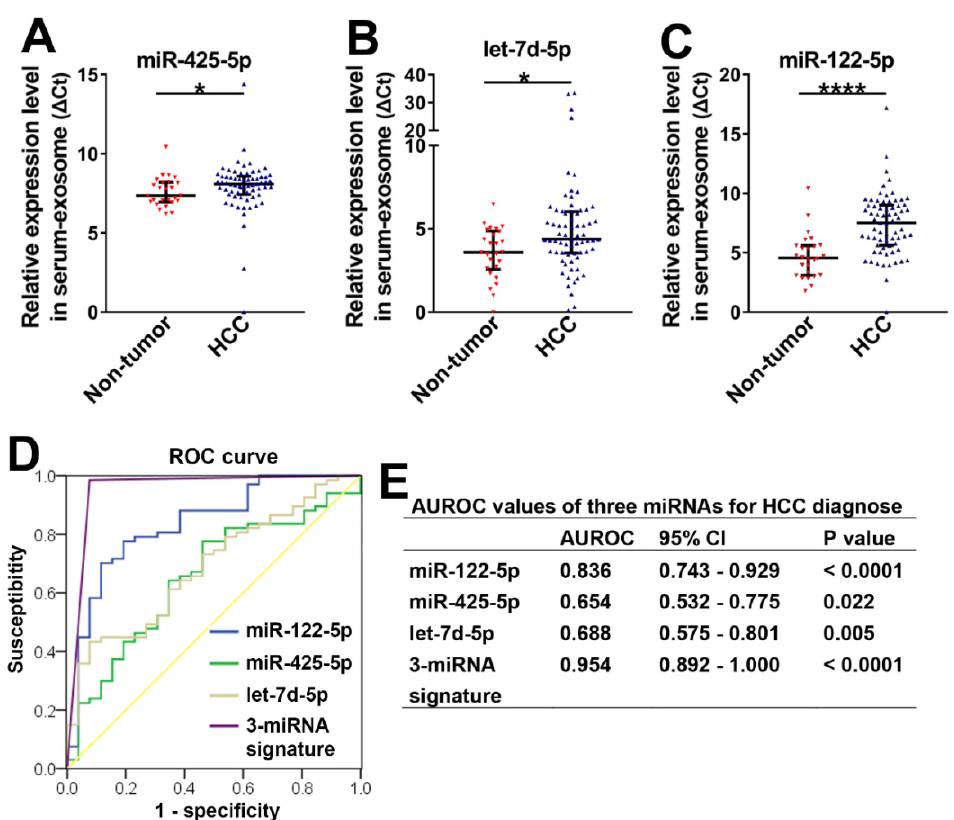
Figure 4. Three serum-exosome-derived miRNAs are significant biomarkers for HCC diagnosis. ( A – C ): qRT-PCR detects the expression levels of the three serum-exosome-derived miRNAs in 69 HCC patients and 26 non-tumor donors (validation set). ( A ): miR-425-5p; ( B ): let-7d-5p; ( C ): miR-122-5p. ( D , E ): Validation set confirms the high value of the three serum-exosome-derived miRNAs in the diagnosis of HCC. * and **** were used to represent p value of < 0.05 and < 0.0001, respectively.